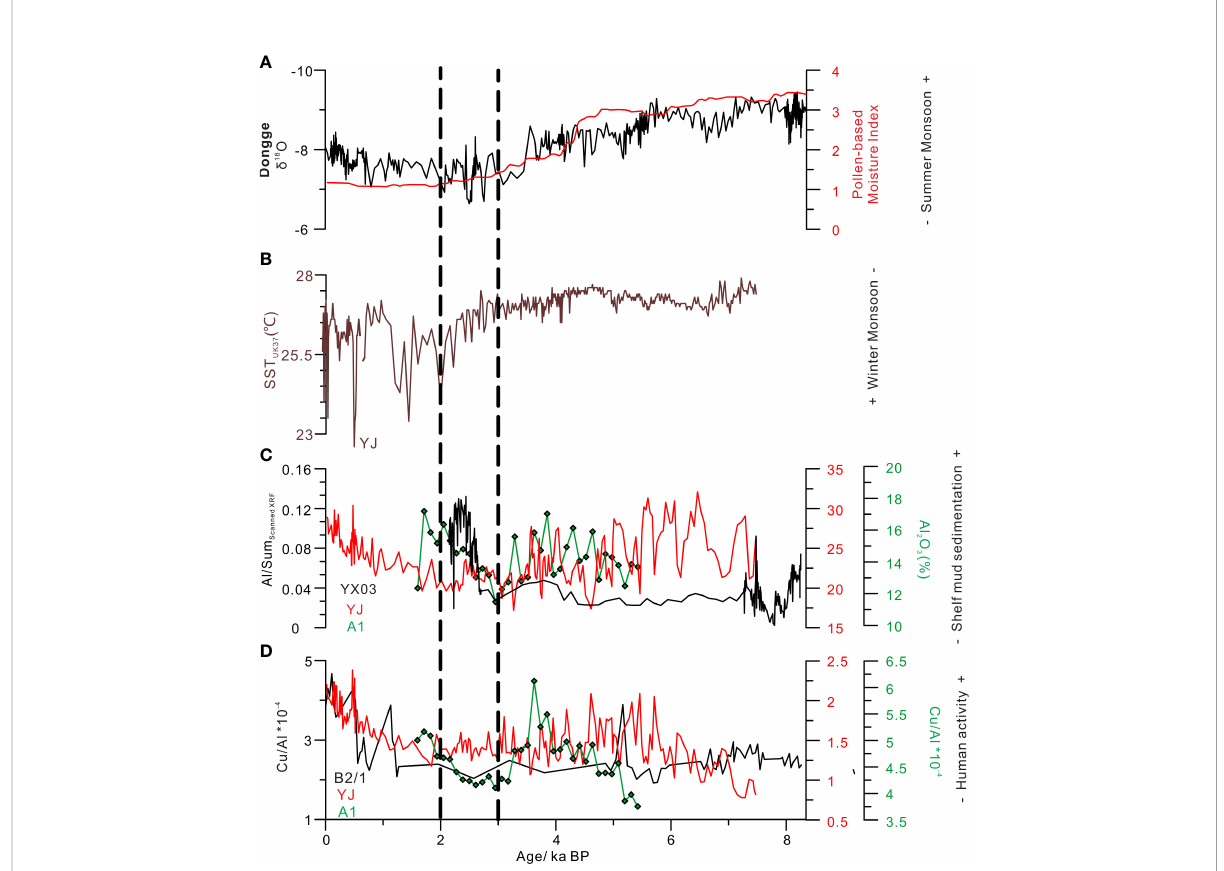
FIGURE 8 Comparison between proxy data of East Asian monsoon, shelf mud sedimentation, and human activities in the northern South China Sea in the past 8ka BP. (A) stalagmite d 18 O record from Dongge Cave (Dykoski et al., 2005); moisture index based on pollen (Zhao et al., 2009); (B) the strength of winter monsoon recorded by alkenone sea surface temperature of core YJ in the northwest SCS Zhang et al. (2019). (C) Al concentrations from cores YX03, YJ (Huang et al., 2008) and A1, recording the initiation of shelf muddy sedimentation; (D) The Cu/Al ratio in the Pearl River estuary (Hu et al., 2013) and on the western SCS shelf (Huang et al., 2018 and this study), showing the enhanced anthropologic activities in recent 2000